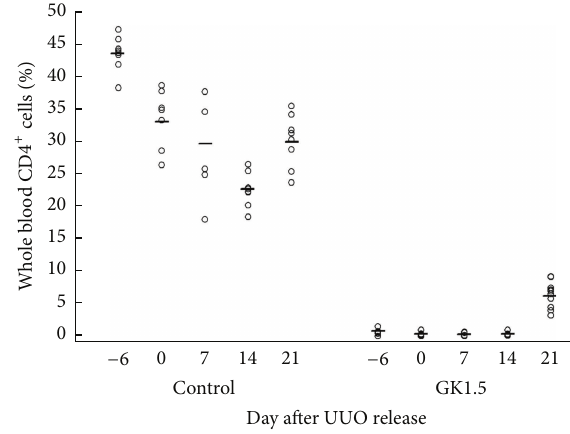
Figure 1: Flow cytometry of PBMCs confirming CD4 + depletion in mice treated with GK1.5.